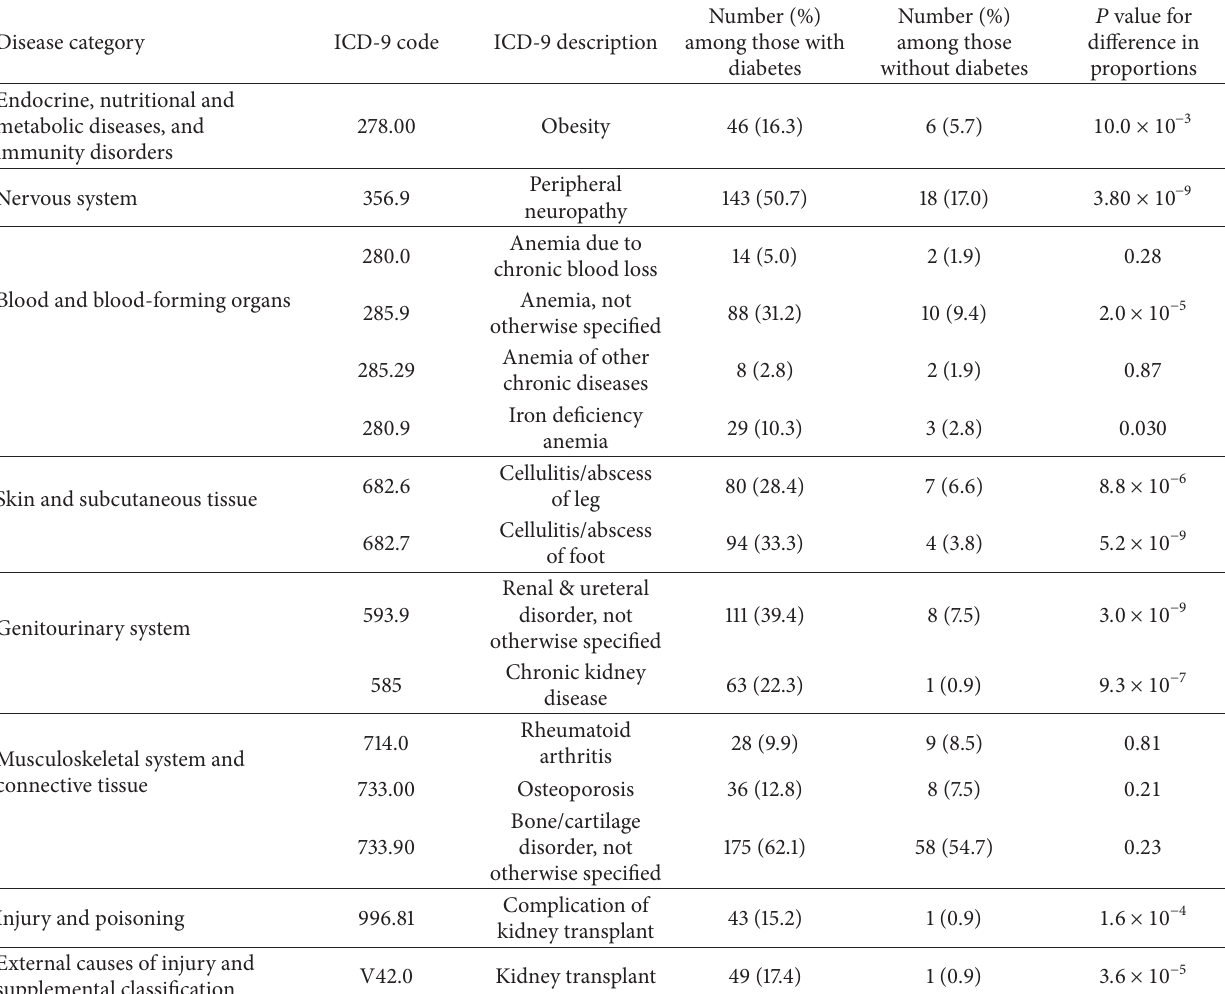
Table 3: Well-known associations with Charcot foot, compared between those with ( 𝑛 = 282 ) and without ( 𝑛 = 106 ) diabetes, defined as any ICD-9 250.x code. The associations shown here are based on the ones shown in Table 1. Disease category among those with among those